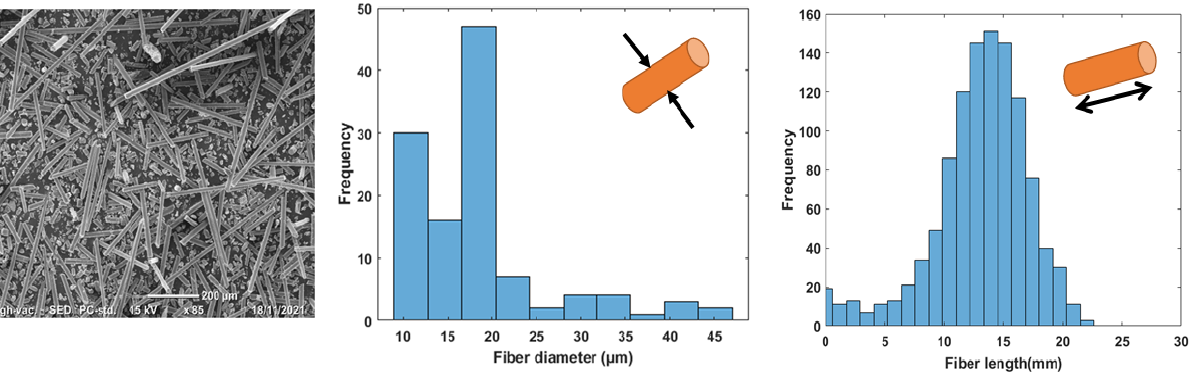
Figure 4. Morphology of WGF: SEM image of fibers ( left ) and fiber diameter distribution ( right